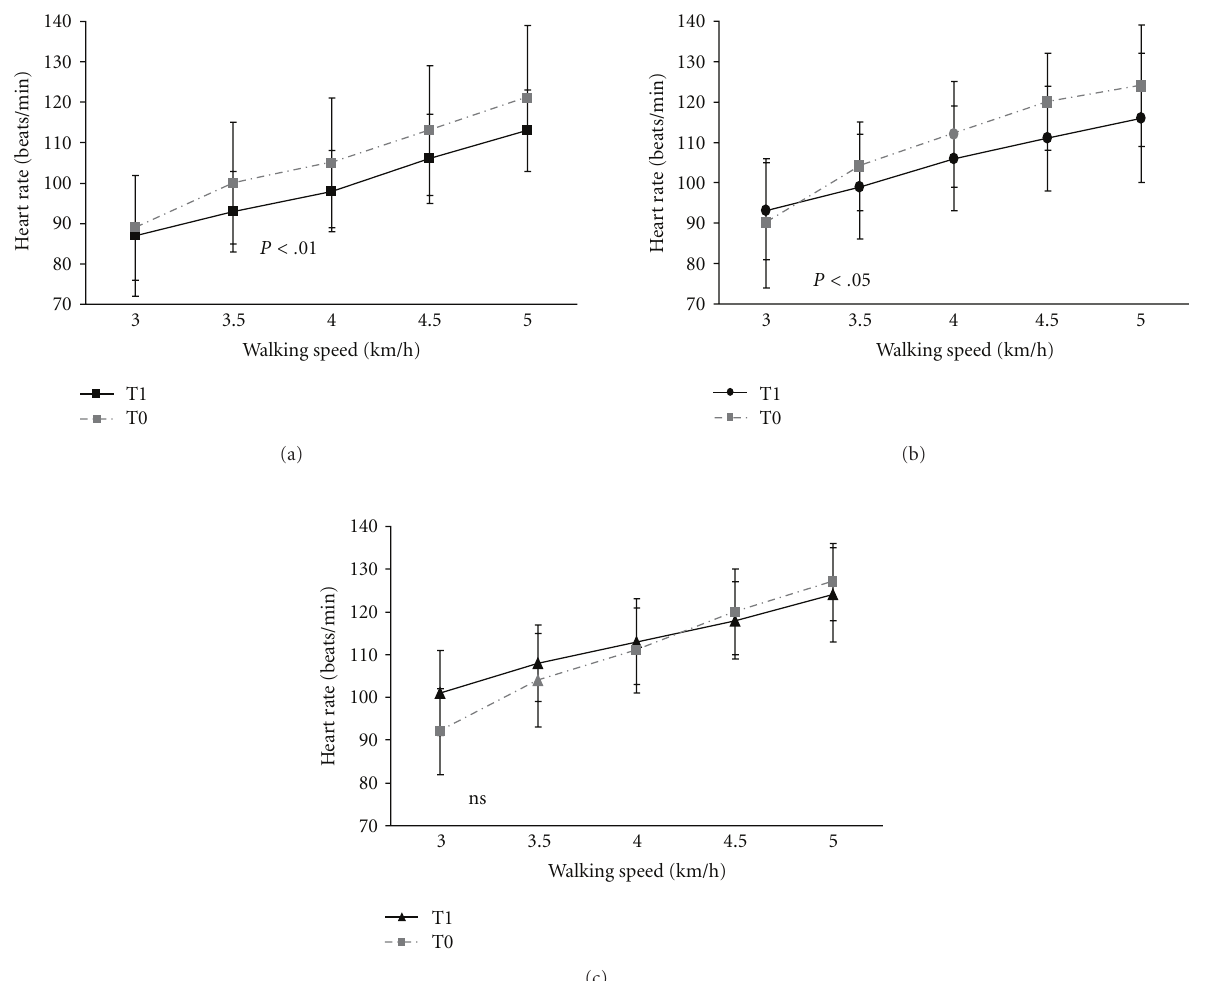
Figure 7: (a) Heart rate increase at submaximal walking speeds was lower in the Nordic walking ((a)) and walking group ((b)) than in the flexibility and relaxation group ((c)) at the second assessment resulting in a significant group e ff ect ( P < . 001). T0 = first assessment, T1 = second assessment, error bars indicate the standard deviation. (b) Walking group: The heart rate response to exercise was significantly lower on the second assessment. T0 = first assessment, T1 = second assessment, error bars indicate the standard deviation. (c) The heart rate of the flexibility and relaxation group (F&R) was only significantly lower at low but not at higher walking speeds. Therefore, the course of heart rate response to exercise was not significantly lower on the second assessment in the F&R group; T0 = first assessment, T1 = second assessment, error bars indicate the standard